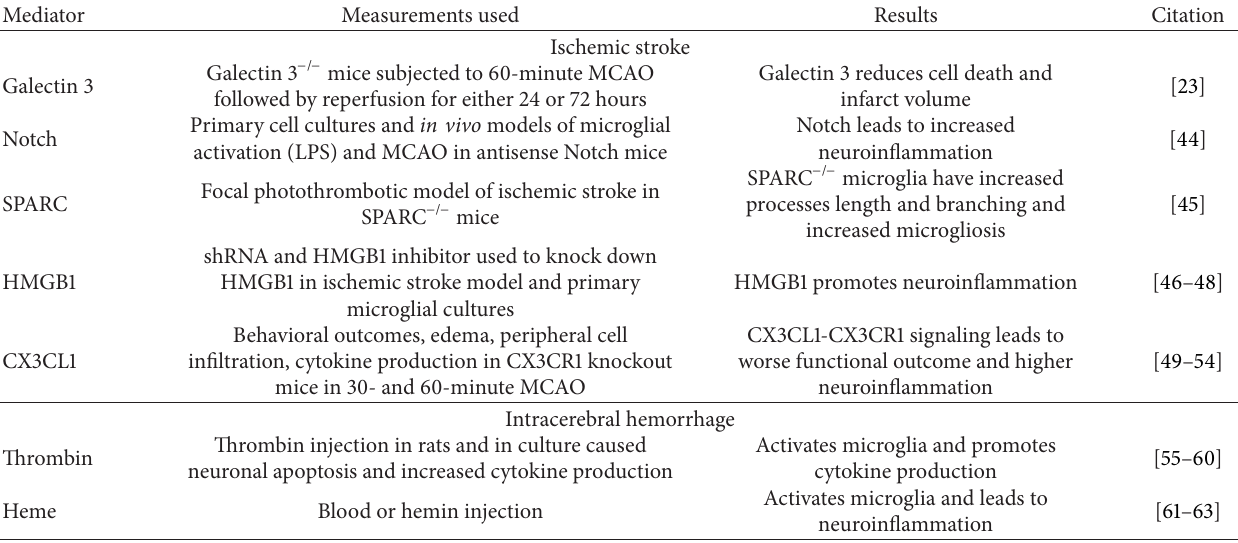
Table 1: Mediators of microglial activation after cerebral ischemia and intracerebral